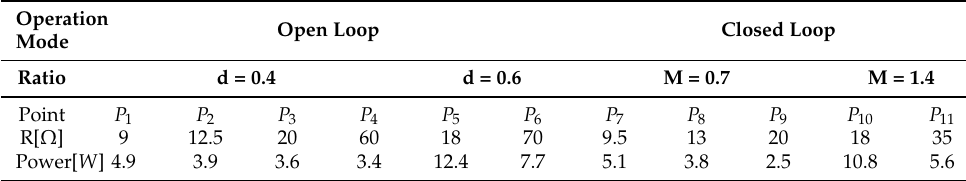
Table 3. Operation points tested in SEPIC and ´Cuk